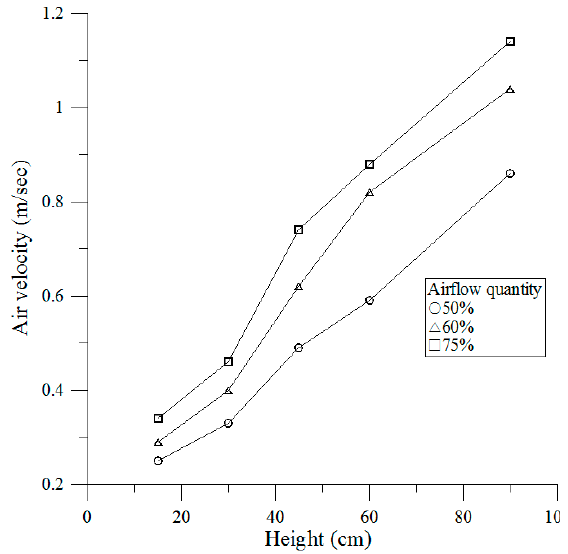
Figure 5. Airflow velocities at different airflow quantity.